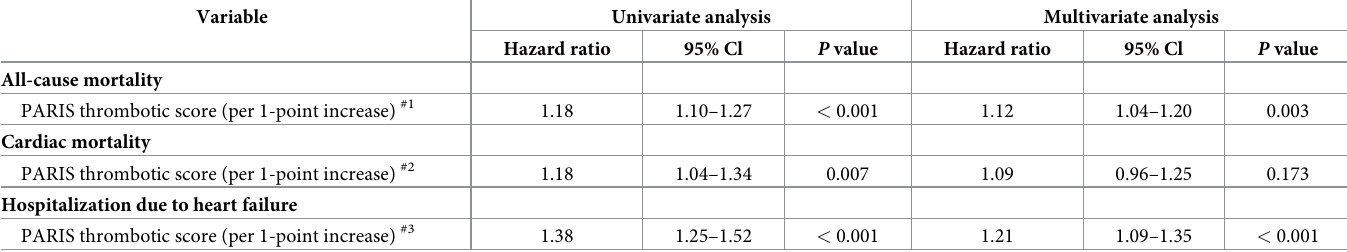
Table 5. Cox proportional hazard model of PARIS thrombotic score (continuous variables) for all-cause and cardiac mortalities and hospitalization due to heart failure.